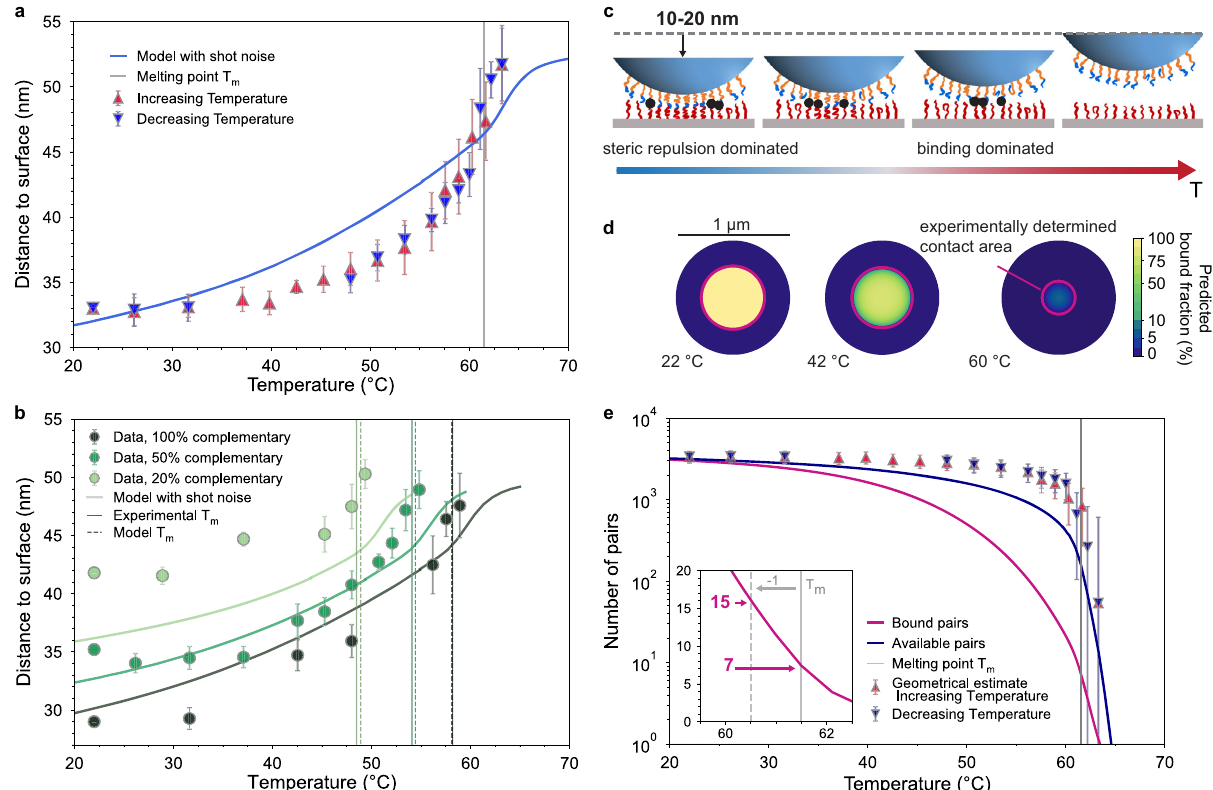
Fig. 4 Microscopic insight into the melting transition. a Height h of potential minimum for a 34 k PEO + A 6 /B 6 particle, measured with TIRM for increasing and decreasing temperatures and model predictions. For this system T m = 61.5 °C. b Height of particles with varying complementary coverage fraction x , with 34 k PEO + A 6 /B 6 ( x %) + T/T 0 (100 − x %), as measured with TIRM for decreasing temperatures. T m = 59.2 °C for the 100% complementary. In the model, a particle density σ p = 0.012 nm − 2 (within the measured density variability) was used to yield the same T m as measured for 100%. No additional fi tting is done for the 20 or 50%. Error bars in a , b correspond to the standard deviation of fi ve particles that are measured at each temperature. c , Sketch of microscopic melting from low to high temperatures. Bonds (which fl uctuate in time) are highlighted with black dots. d Contact area with radius r ’ 2 a ð h max (cid:2) h Þ where h is the separation distance from a and h max ’ 52nm the maximal interaction height. Here 2 a = 5 μ m. Overlapped model predictions show the proportion of bound pairs over the particle ’ s bottom surface. e Number of pairs within range (available) for binding calculated from experimental data of a as π r 2 σ g with r from d . Error bars correspond to 6% uncertainty on h max . Model prediction for the average number of available and bound pairs and (inset) zoom around T m (Supplementary Discussion Section 3.7). Model parameters for d , e correspond to those of a